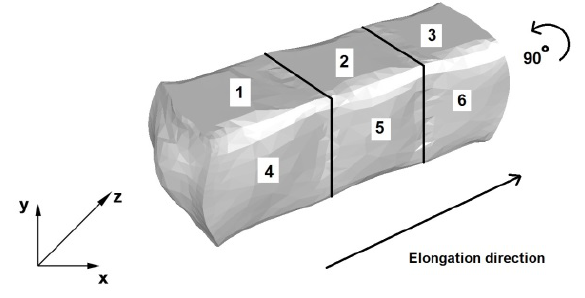
Figure 5. Flat die elongation process diagram.